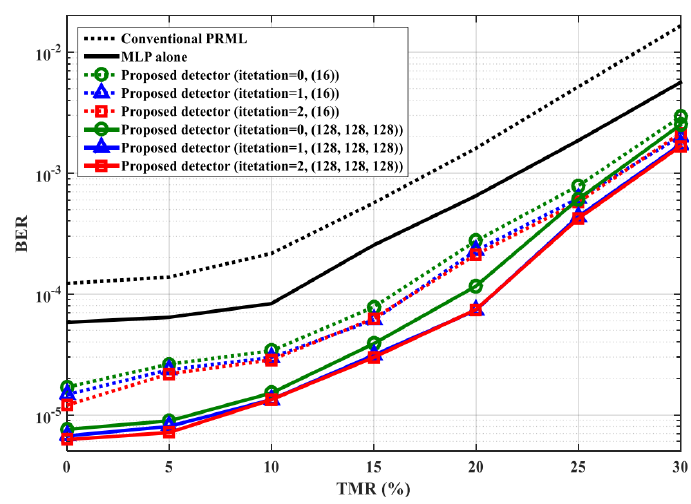
Figure 5. BER performance depending on TMR at SNR of 20